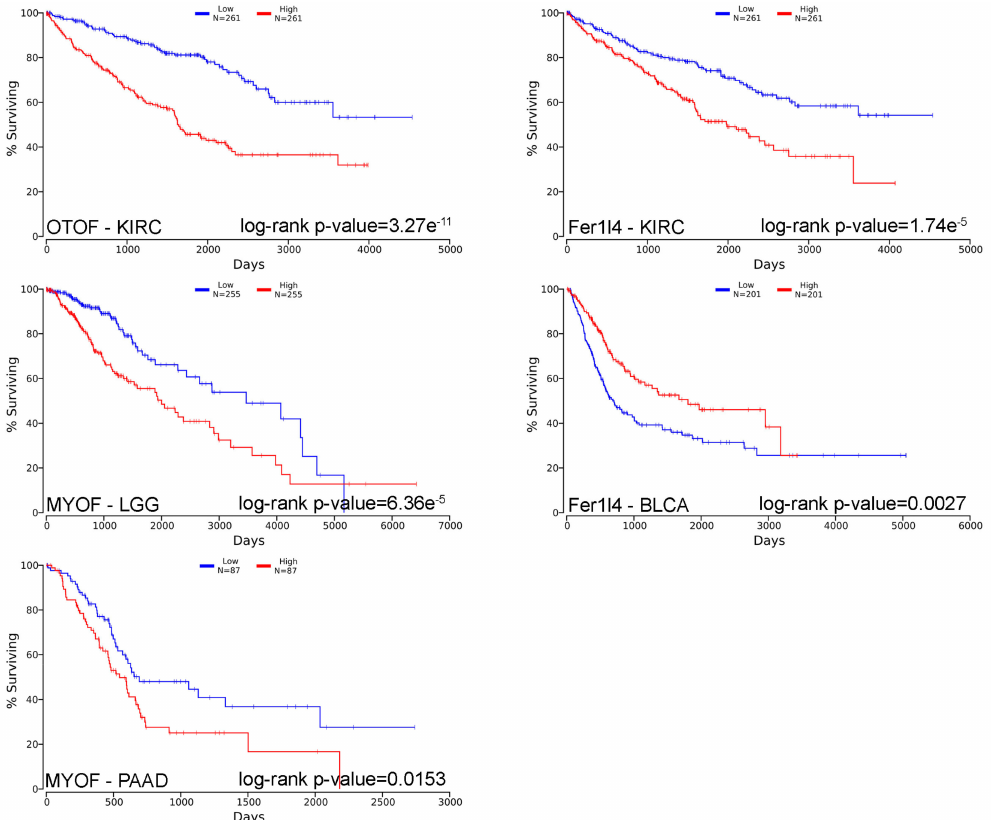
Figure 3. Kaplan-Meier survival curves of patient cohorts with di ff erent cancer types. Ferlin gene expression was segregated in low (blue) and high (red) expression according to median in kidney renal clear cell carcinoma (KIRC), brain lower grade glioma (LGG), bladder urothelial carcinoma (BLCA), and pancreatic adenocarcinoma